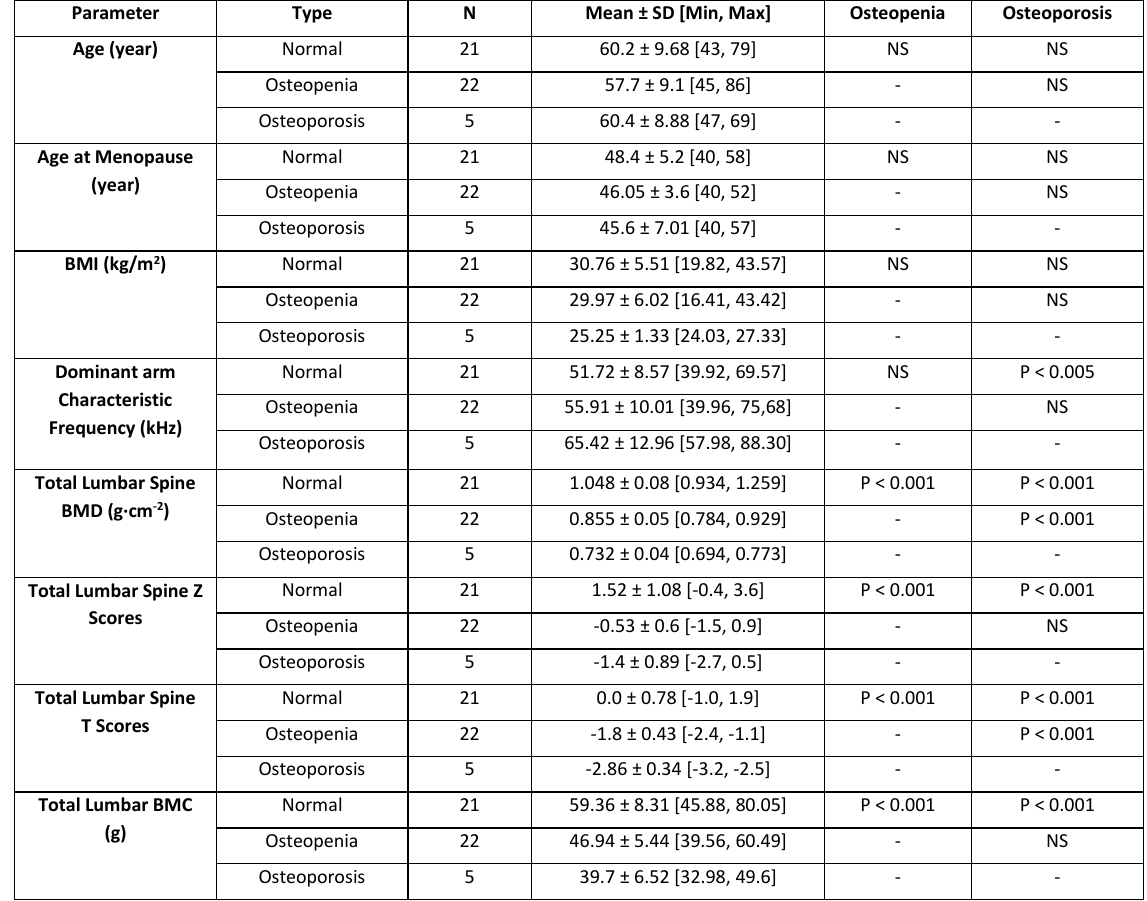
Table 1. The classification and statistical analysis of patients based on lumbar spine BMD